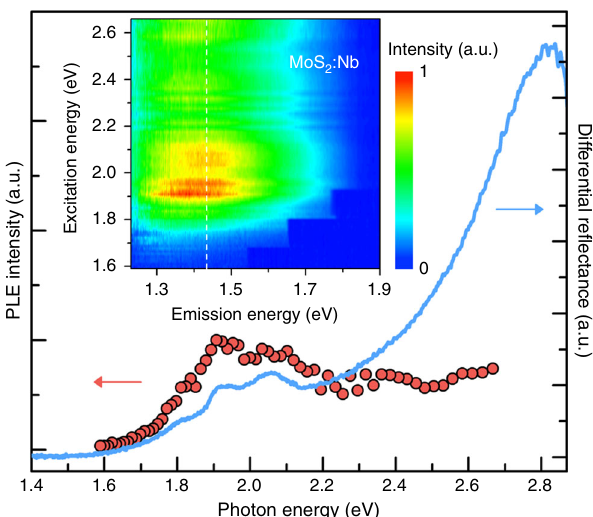
Fig. 5 Photoluminescence excitation (PLE) data of the monolayer MoS 2 :Nb (1%). Left and right y axis correspond to PL emission energy at 1.43 eV and differential re fl ectance spectra ( Δ R / R ), respectively, as a function of excitation energy. Top inset displays PLE intensity 2D map where the color scale represents emission intensity, and was collected with an excitation power of ~0.5 μ W at 300